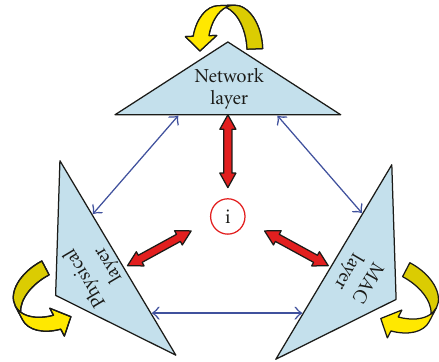
Figure 1: Hierarchical cross-layer design model: interactions among physical, MAC, and network